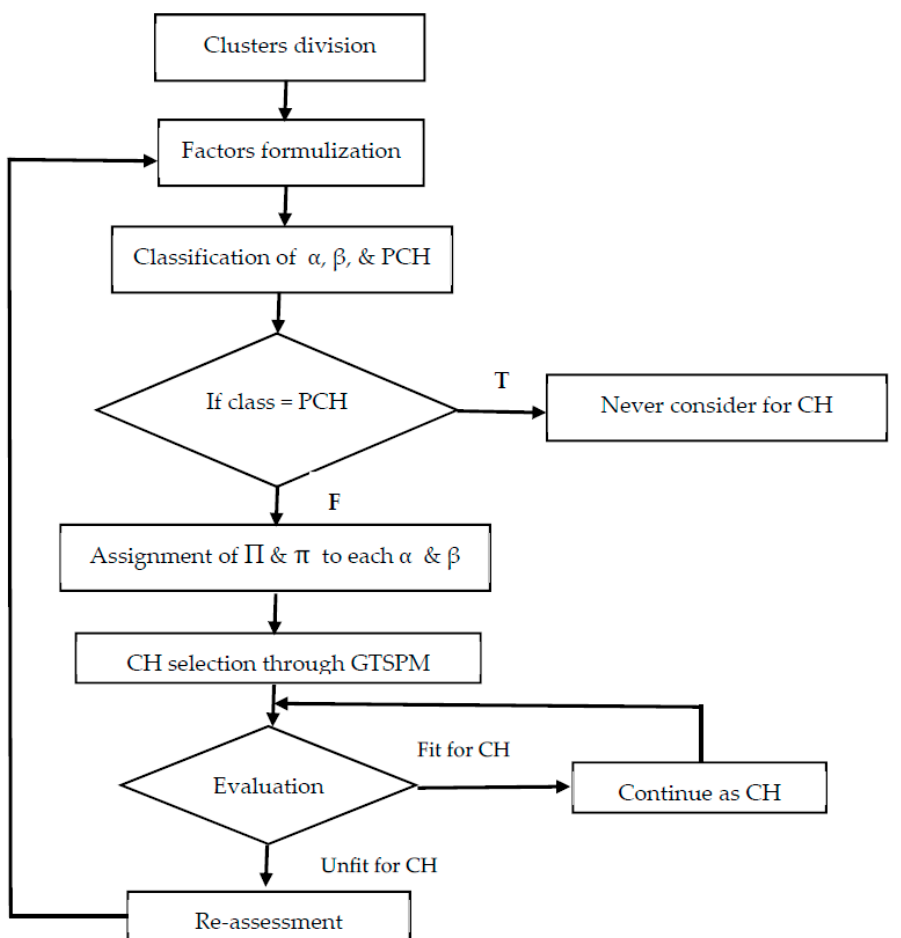
Figure 2. Flowchart to clearly show the proposed scheme.